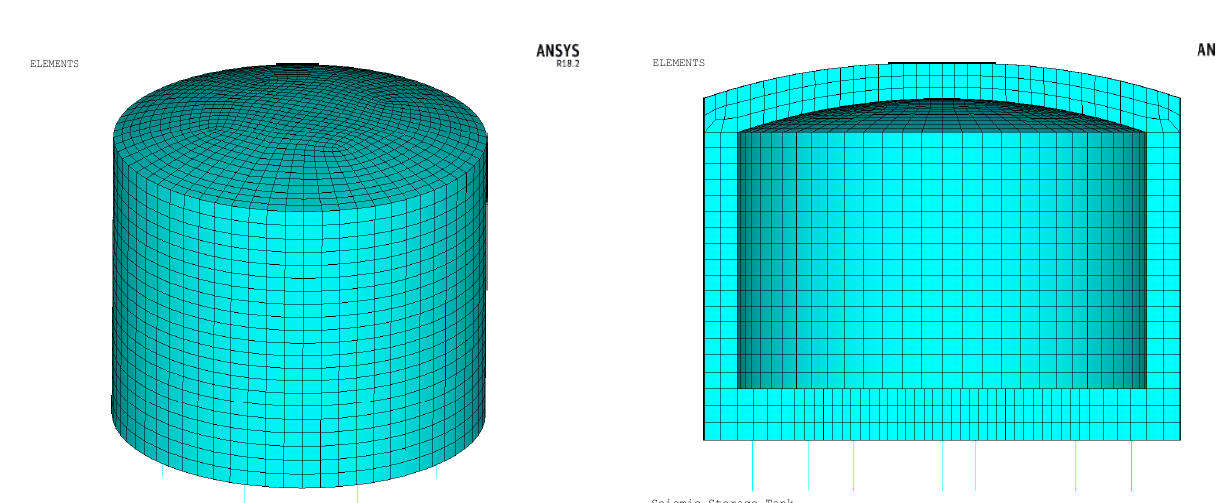
Figure 8. Finite element model of the LNG storage tank.